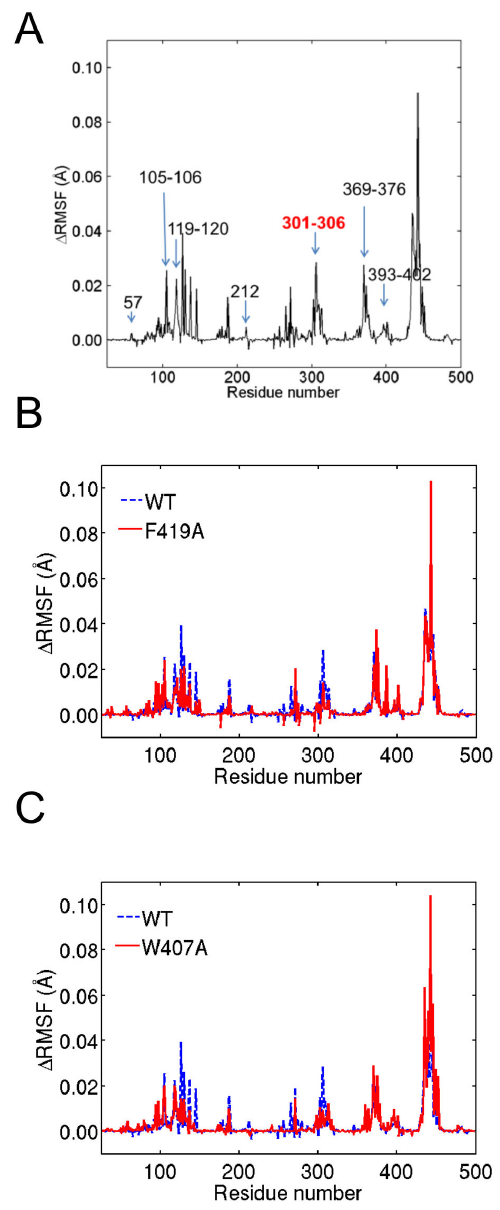
Figure 7. Residue-based root mean square fluctuations (ΔRMSFs). ΔRMSFs were calculated from low-temperature anisotropic thermal diffusion (ATD) simulations to identify residues that exhibit long-range correlated motions to a locally heated heme group in the CYP3A4 structure. A : WT CYP3A4 residues that interact with NR are labeled as numbers or number ranges and partially overlapped with the ΔRMSF peaks. Key residues 301-306, which provide the means to change the NR reaction products, are shown in red. B and C : ΔRMSFs for the F419A mutant compared with the WT ( B ) and for the W407A mutant compared with the WT ( C ). The sequence range that encompasses 301-306 is indicated by blue ovals. All residue numbers refer to the CYP3A4 sequence (PDB code 1W0E). doi: